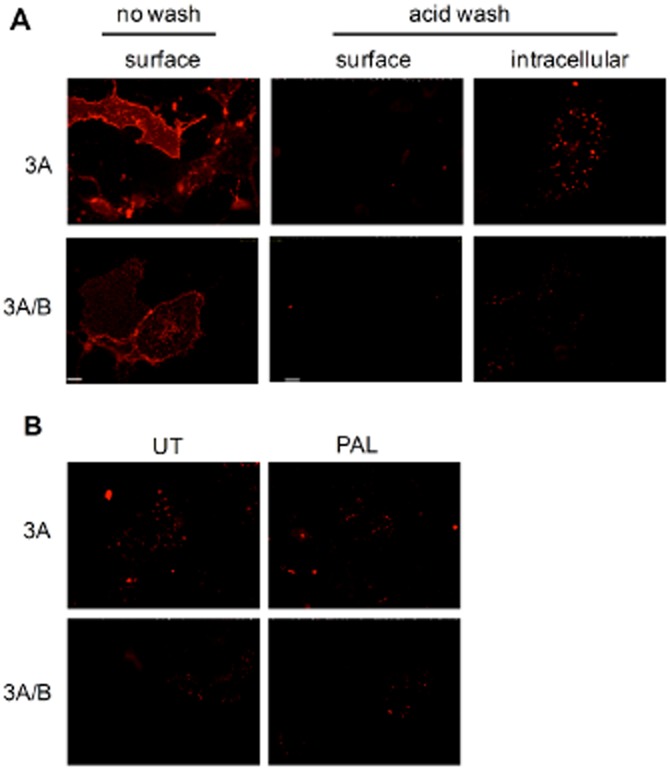
5-HT3 receptor internalization is not induced by palonosetron (PAL). (A) COS-7 cells expressing 5-HT3A-myc (3A) or 5-HT3A-myc/B-HA (3A/B) were probed with anti-myc or –HA antibodies (4°C, 60 min). Cell surface receptors were identified using Alexa 568 conjugated secondary antibody (surface). Receptor internalization (37°C, 30 min) was identified following the removal of surface antibody by a low pH (acid wash) and probed with the secondary antibody (surface). Internalized receptors were detected following permeabilization (intracellular). (B) Cells were pre-bound with primary antibodies, as above. They were then incubated in the absence or presence of palonosetron (1 nM, 30 min, 37°C). Cells were then permeabilized and probed with secondary antibody. Images represent at least three separate experiments. Scale bar = 50 μm. UT, untreated.